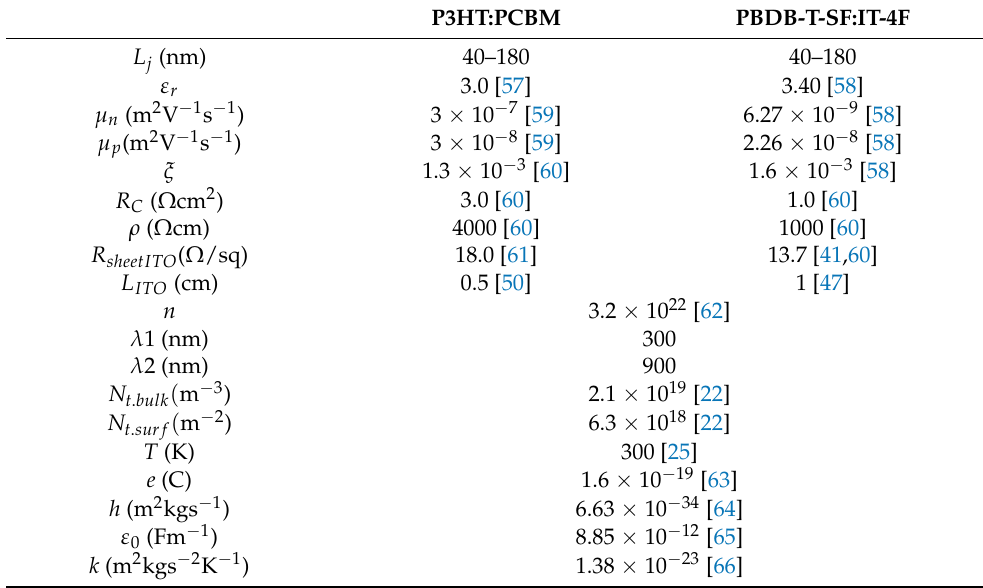
Table 1. Input parameters required in the